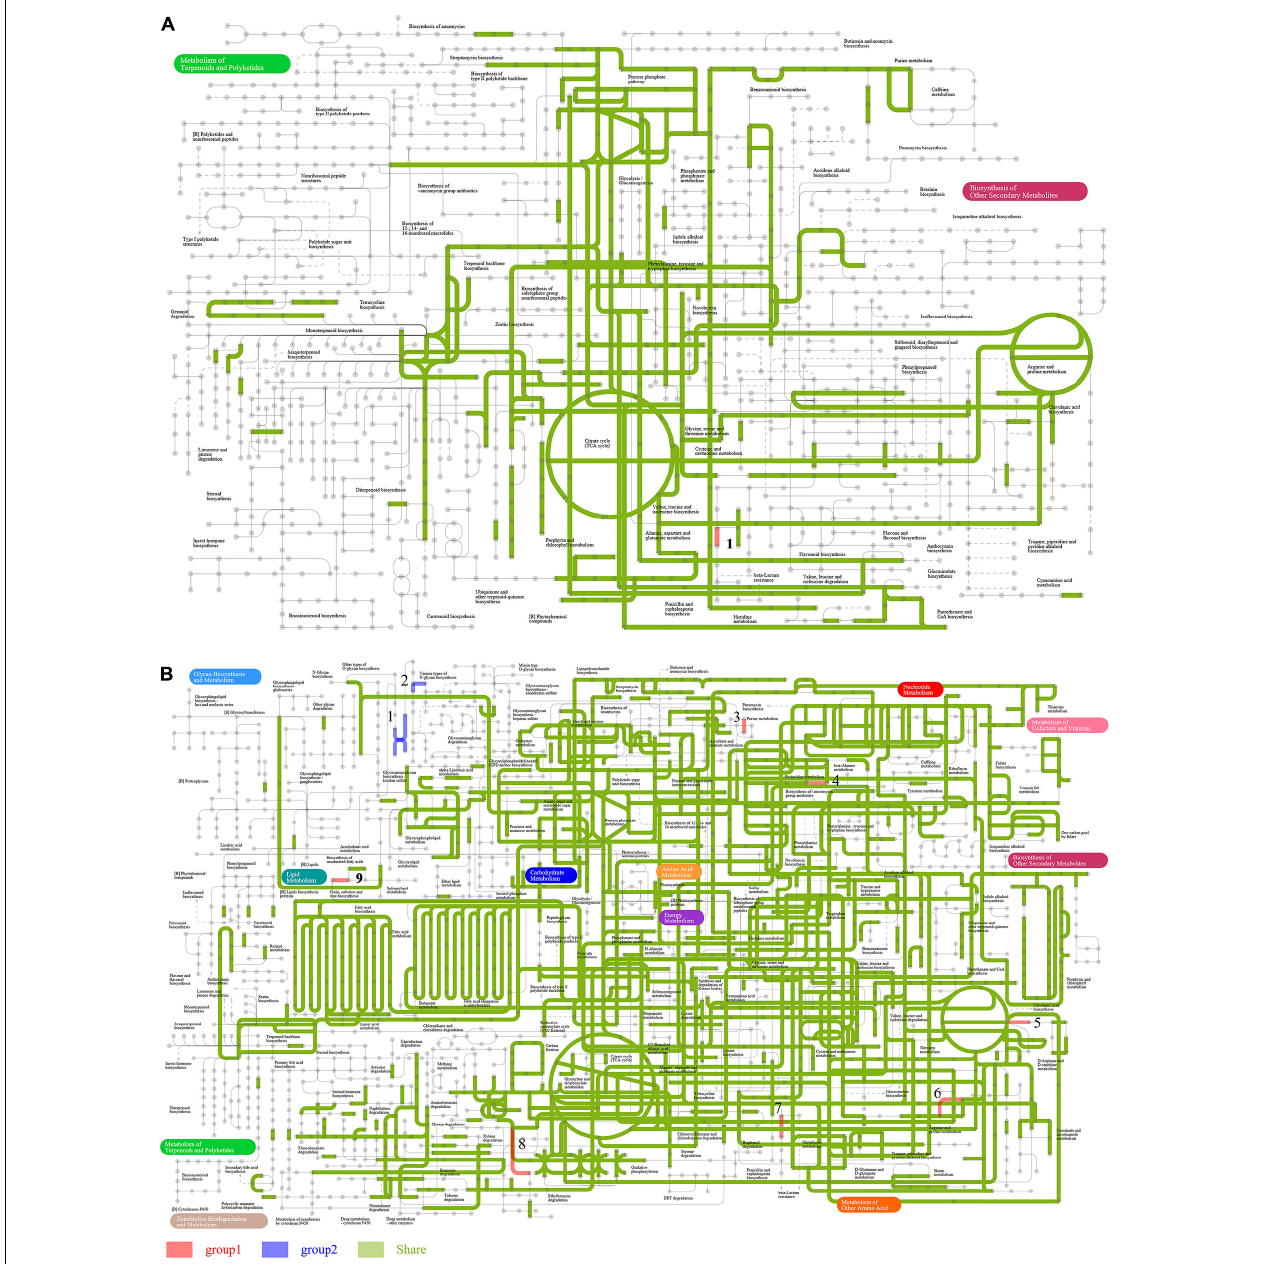
FIGURE 7 | Comparison of ipath metabolic pathways between FBT-type communities. Red and blue lines indicate unique metabolic pathways for FBT_H and FBT_S communities, respectively, while green lines indicate shared metabolic pathways among the two samples. (A) Biosynthesis of secondary metabolites and overall (B) metabolic